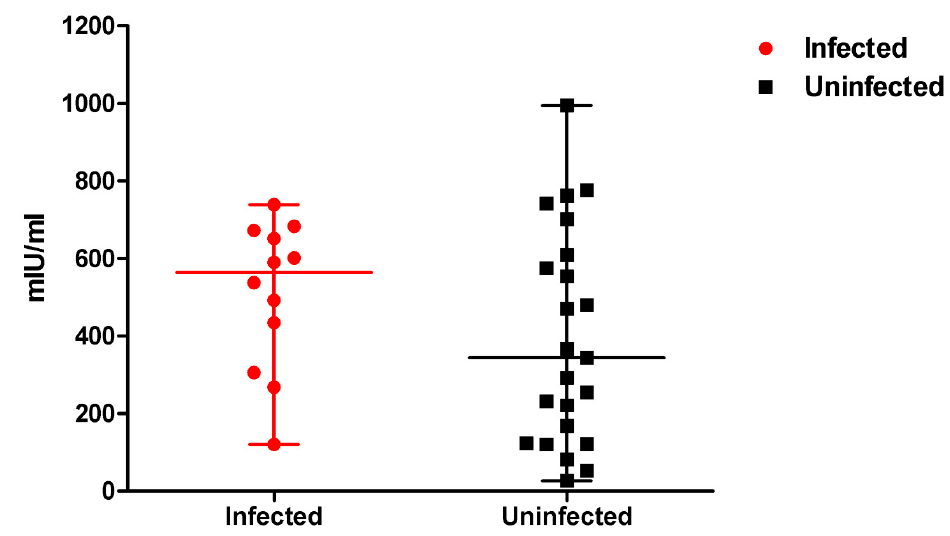
Figure 5. SARS-CoV-2-specific T-cell response after booster vaccination in COVID-19-infected and uninfected students.